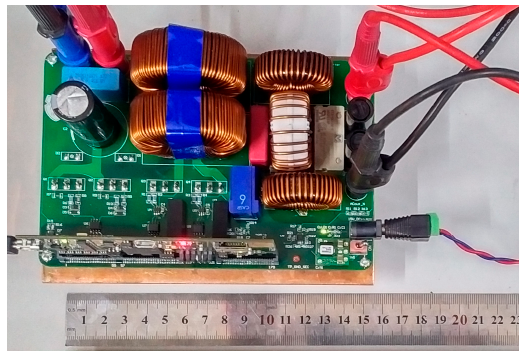
Figure 15. Experimental prototype. Table 2. Parameters of the proposed system.